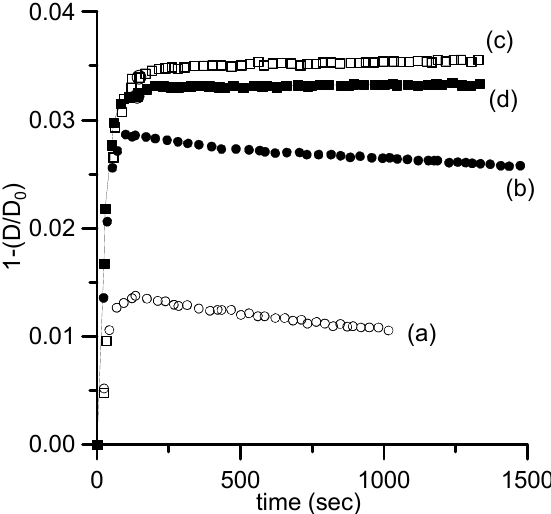
Figure 10. Representation of the polymerization shrinkage 1 − (D/D containing 5 mg (open symbols) and 10 mg PMMA/0.5 g aerosil (black symbols), respectively. Curing conditions were 1 × 20 s, ( a , b ) and 5 × 20 s, ( c , d ),